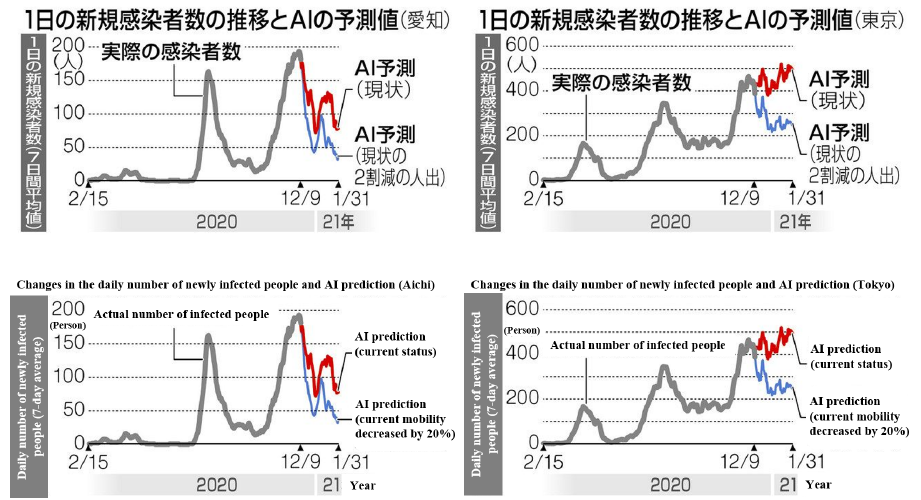
Figure A1. Estimated number of positive cases in Aichi prefecture ( left ) and Tokyo metropolitan ( right ). The red color indicates the case wherein there was no change in public mobility, and blue indicates the case where mobility reduced to values equivalent to August 2020. These plots were published on 12 December 2020. English version is shown below the original charts in